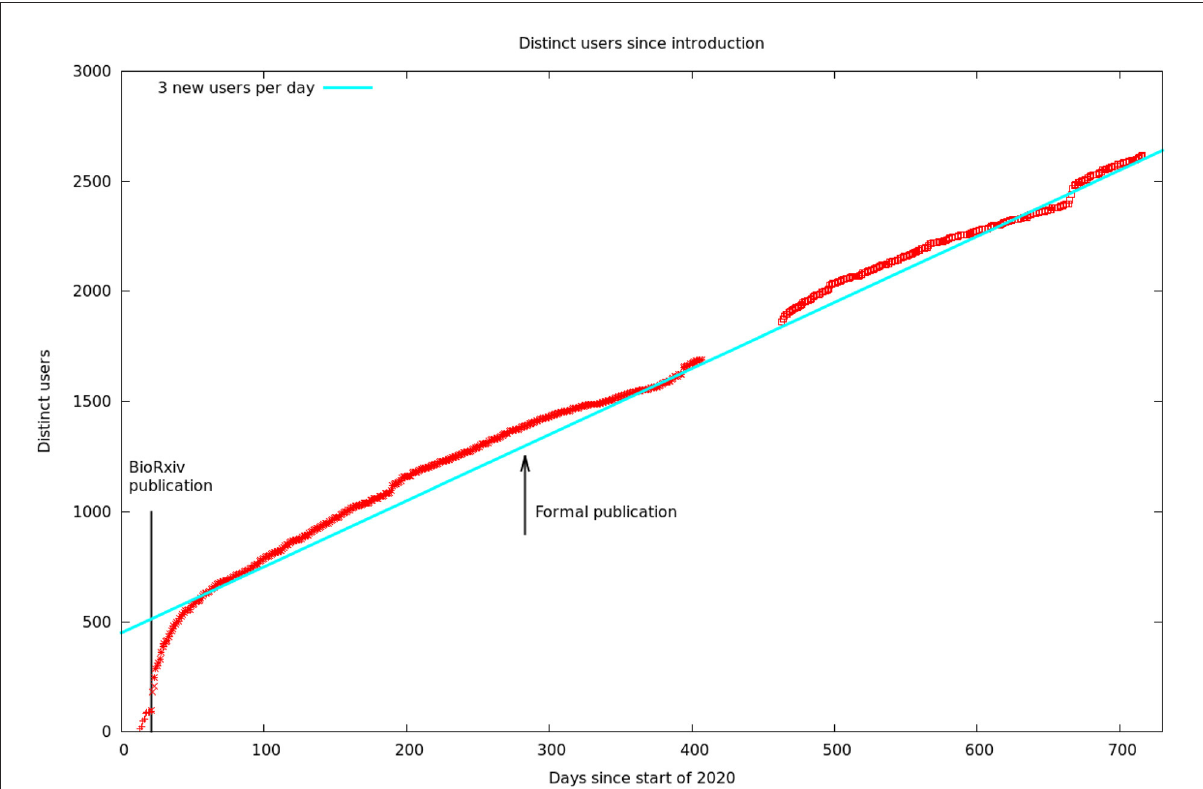
FIGURE6 Cumulative unique visitors. The solid line is a hypothetical rate of three new users per day. We assumed this rate during our data gap, as this is consistent with the rest of our data. The solid line to the left is the date of publication of the first bioR χ iv paper. The arrow shows the later formal publication in eLife that contained better cell typing, analysis, and